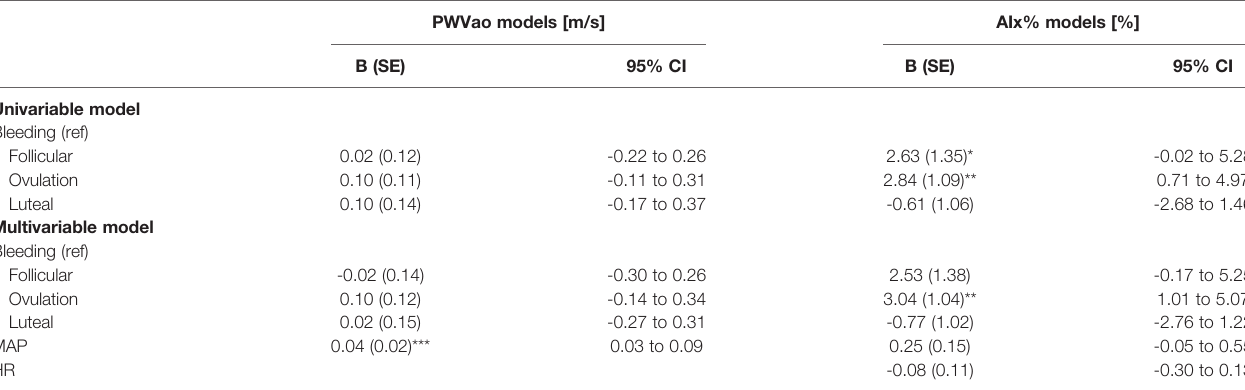
TABLE 5 | Association of menstrual cycle stages with arterial